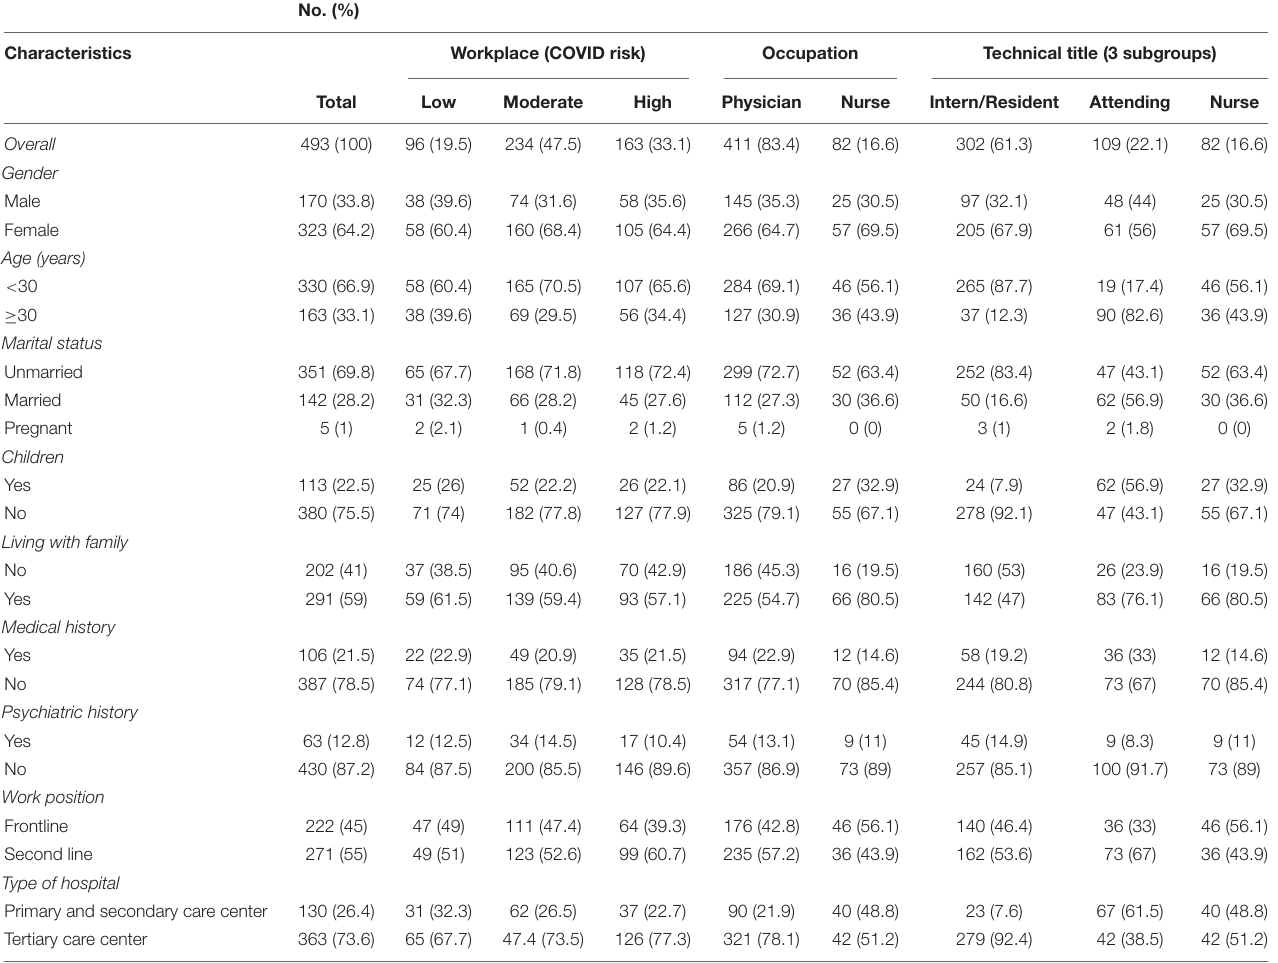
TABLE 1 | Demographic and occupational characteristics of